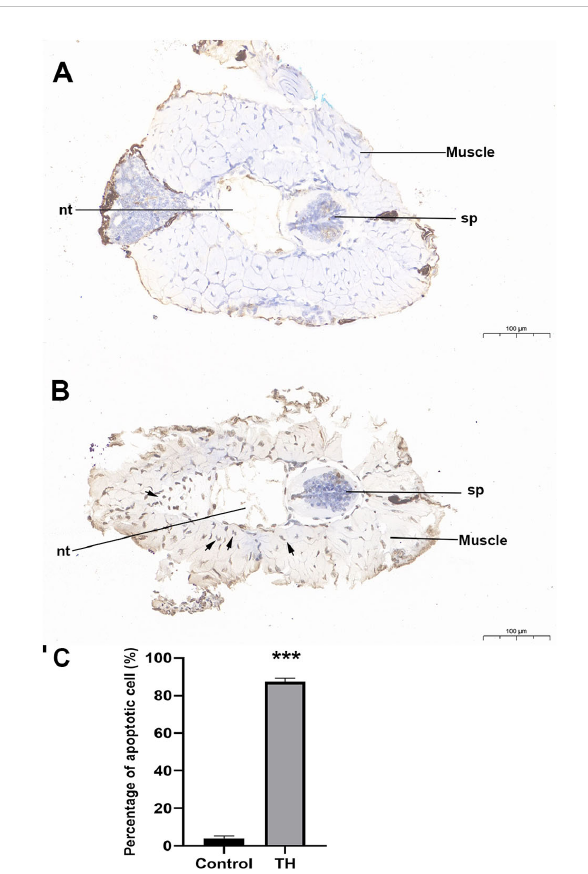
FIGURE 4 Representative images of TUNEL staining of dorsal of Microhyla fi ssipes in control group (A) and TH treatment group (B) (magni fi cation, ×15; scale bar, 100 m m). (C) Apoptosis cells rate in the dorsal muscle of control and TH exposure. Nuclei stained with hematoxylin are blue, while the positive apoptosis cells developed by DAB reagent have a brown-yellow nucleus. Arrow, TUNEL-positive cell; nt, notochord; sp, spinal cord; TH, thyroid hormone. *** indicate signi fi cant differences between samples at p < 0.001 based on ANOVA analysis.